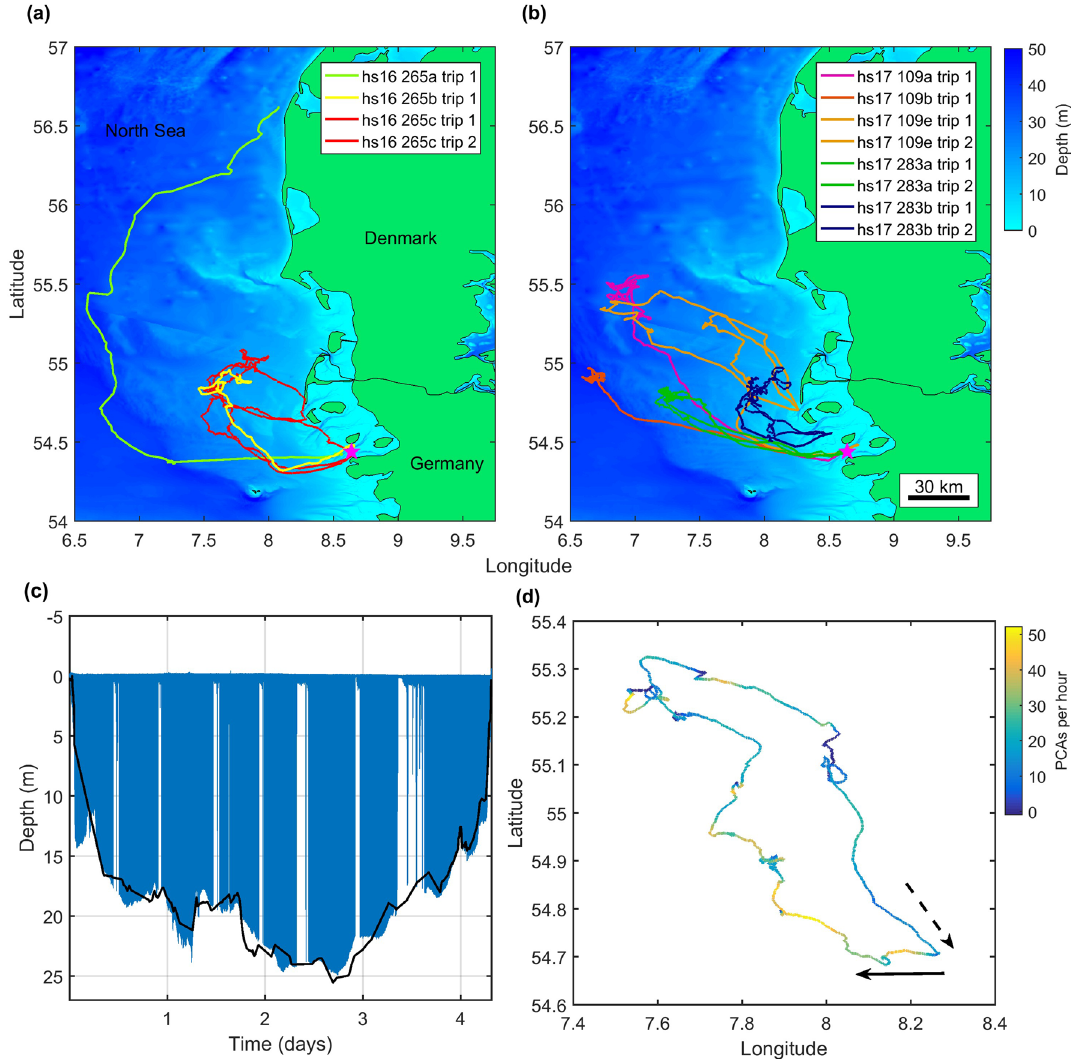
Figure 1. ( a ) GPS surface tracks of animals tagged in 2016. These represent 4 multi-day foraging trips by 3 individuals. One seal (hs16_265a) did not return to the same haul-out site but rather travelled north to Limfjord in Denmark. ( b ) GPS surface tracks of animals tagged in 2017. These represent 8 multi-day foraging trips performed by 5 animals. In six of these offshore trips (2016 and 2017), the tags stopped recording before the seal returned to shore. The tagging site is represented in both ( a ) and ( b ) by a purple star. ( c ) Dive profile of hs17_109e trip2 with the black line indicating bathymetry interpolated from www. emodn et. eu/ bathy metry. ( d ) Dead-reckoned horizontal track of hs17_109 trip 2, coloured by the hourly rate of presumed prey capture attempts (PCAs), inferred from acceleration, showing continuous foraging during both straight-line travel to and from offshore prey patches and during more tortuous movements while offshore. The continuous arrow indicates the track of the animal moving away from the haul-out towards offshore areas, while the broken arrow indicates the track of the animal returning to the the highest proportion of HVPs occurred in the last days of the trip including the return journey (Fig. 4b). To control for potential bias in HVP counts due to shorter dives as animals approach shallower coastal waters dur- ing return travel, we repeated this test excluding dives shallower than 10 m and found a similar result. Typically, 15–25 large prey captures were detected per day but considerably higher rates were found in two offshore trips foraging trip indicating that perhaps larger prey have an unpredictable distribution or that seals do not target them consistently. The median distance made good between PCAs (i.e., the straight-line distance between PCA locations) across all animals was 44.2 m. However, the inter-quartile range (IQR) for each animal was large, reflecting a high variability in prey distribution (Table 1). The median distance travelled between prey encounters (i.e., the sum of distances between samples in the dead-reckoned tracks) was 67.9 m also with a high IQR indicating